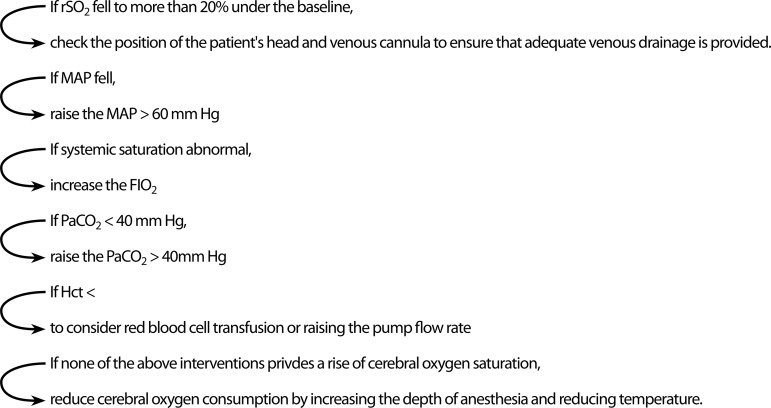
Algorithm for the treatment of cerebral desaturation.FiO2=fraction of inspired oxygen; Hct=hematocrit; MAP=mean arterial pressure; PaCO2=partial carbon dioxide; rSO2=regional cerebral oxygenation